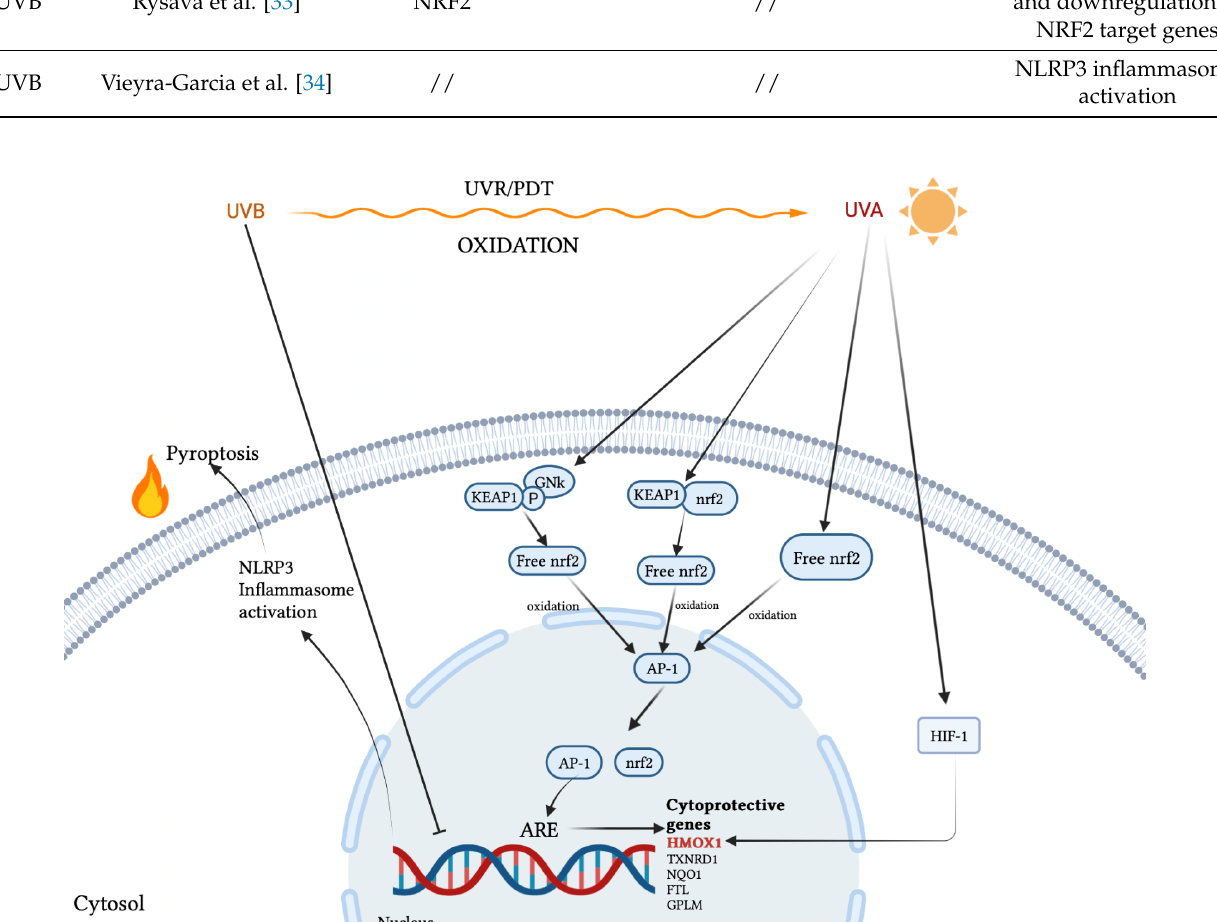
Figure 2. proportion of non-serious/Grade <3 AEs for pediatric patients receiving antiangio- Figure 2. UVR modulation on the expression of cytoprotective genes. The figure shows the dia- genic drugs as monotherapies (drugs assessed in less than 20 patients or not reporting both non- metrically opposite effects of UVA and UVB. UVA-mediated oxidation acts on two different serious/Grade <3 AEs).